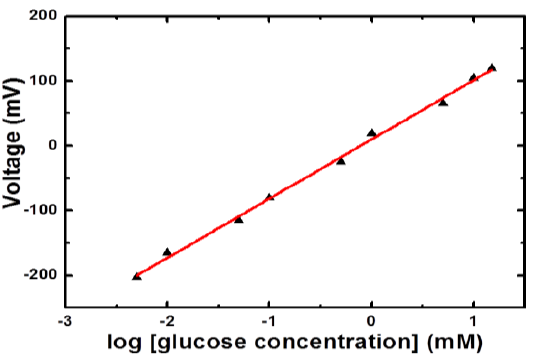
Figure 4. The calibration curve of glucose biosensor based on NiCo linear concentration range of 0.005 mM to 15